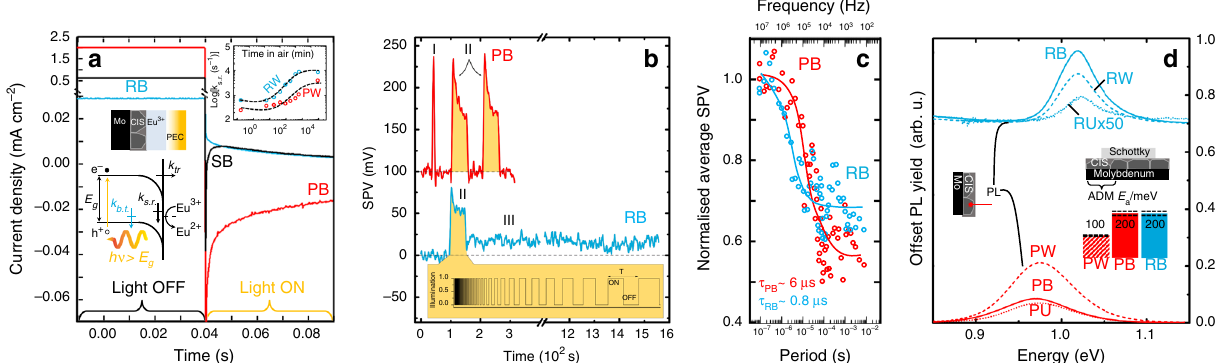
Fig. 6 Electrical identi fi cation of the metastable defects induced by cyanide etching on CuInSe 2 absorbers. a PEC transients of Cu-poor CIS (P, red), stoichiometric CIS (S, black) and Cu-rich CIS (R, blue) fi lms immediately after bold KCN etching ( b ) (hence: PB, SB and RB). Inset: evolution of the surface recombination kinetic constant ( k s.r. ) of CIS-P (red) and CIS-R (blue) as a function of air-exposure time after weak KCN etching (W) (hence, PW and RW). Schematics: band diagram of the CIS/electrolyte junction with an additional recombination pathway and corresponding bulk trap kinetic constant ( k b.t. ). b TR-SPV results on CIS- P (red, shifted by 100 mV) and CIS-R (blue) with bold KCN etching (B). The relaxation curve of CIS-PB acquired in real time after excitation with a continuous-wave light source with 1 – 2 s duration (Region I) shows a fast decay time, which cannot be resolved by KPFM. To resolve it, modulated illumination was used to obtain frequency spectra (during which a partial SPV decay is observed, region II). Unlike CIS-PB, where the SPV drops sharply to the initial in-dark value after the modulation sequence, CIS-RB does not recover completely (region III). The light modulation sequence has a 50% duty cycle for a total duration of 5.2 s, as shown by the schematic square-wave in the yellow inset. c Normalized average SPV spectra as a function of the illumination modulation frequency (corresponding to region II). Decay times ( τ ) are determined by fi tting (solid thick lines) the data (open circles) with an exponential behaviour yielding: τ PB ~ (6.2 ± 1.0) µ s and τ RB ~ (0.75 ± 0.2) µ s (cf. “ Methods ” ). d PL yield of CIS-P (red) and CIS-R (blue) fi lms without etching (U, dotted), and after weak KCN etching (W, dashed) and bold KCN etching (B, solid line). Inset: activation energies of the main capacitance step extracted from the slope of the Arrhenius plots of the thermal admittance spectra (320 – 50 K) of Schottky junctions with CIS-P (red) and CIS-R (blue). Bold KCN etching yields an activation energy of 200 ± 20 meV on both CIS-P and CIS-R, whereas CIS-PW shows an activation energy of 100 ± 10 pathway apparent in Cu-rich CIS after bold etch (Supplementary